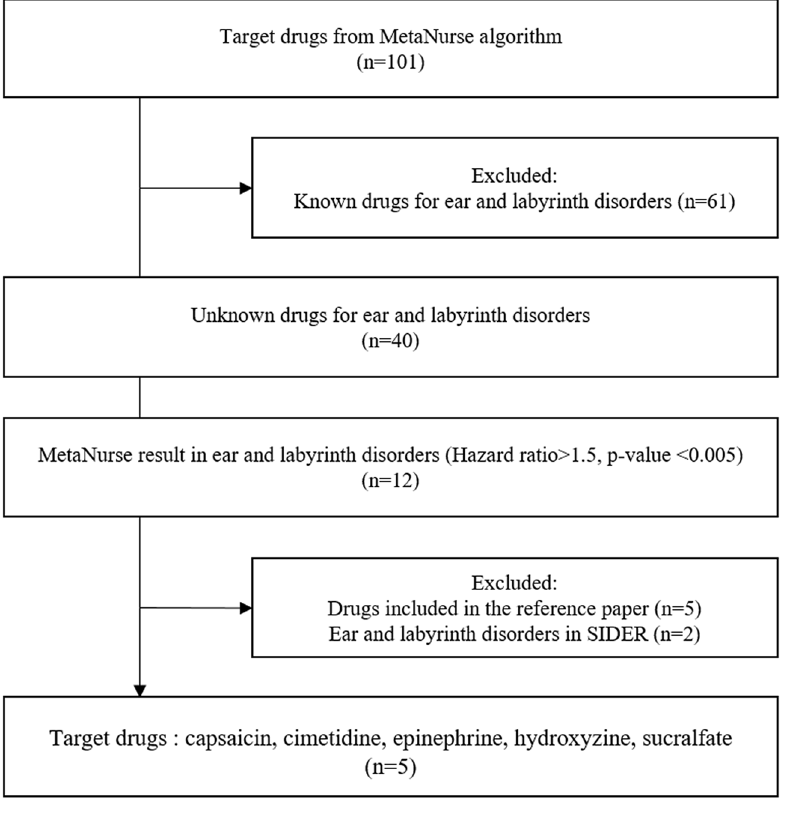
Figure 1. Process for target drug selection using the MetaNurse